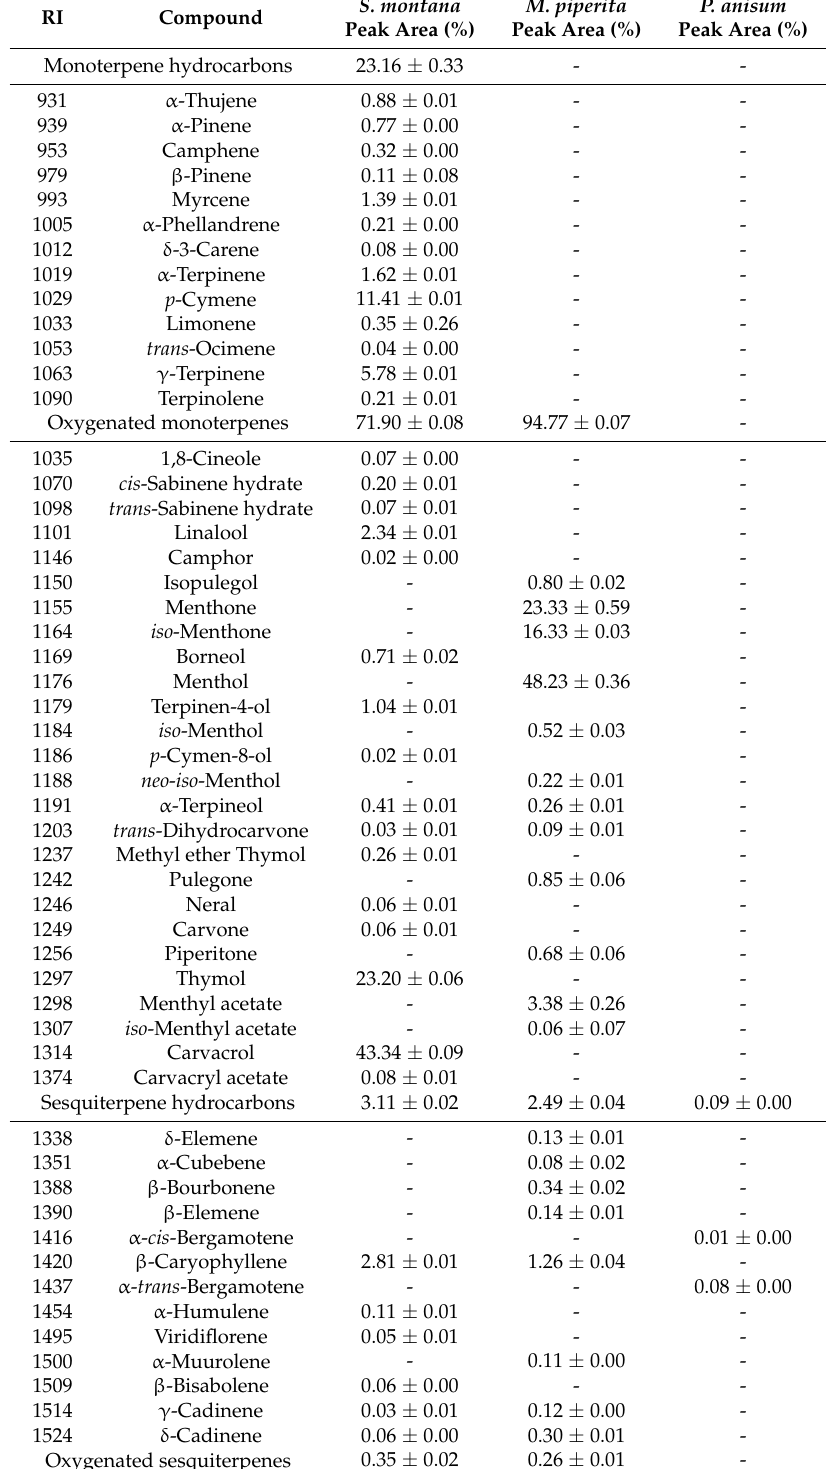
Table 1. Chemical composition of commercial S. montana , M. piperita , and P. anisum essential